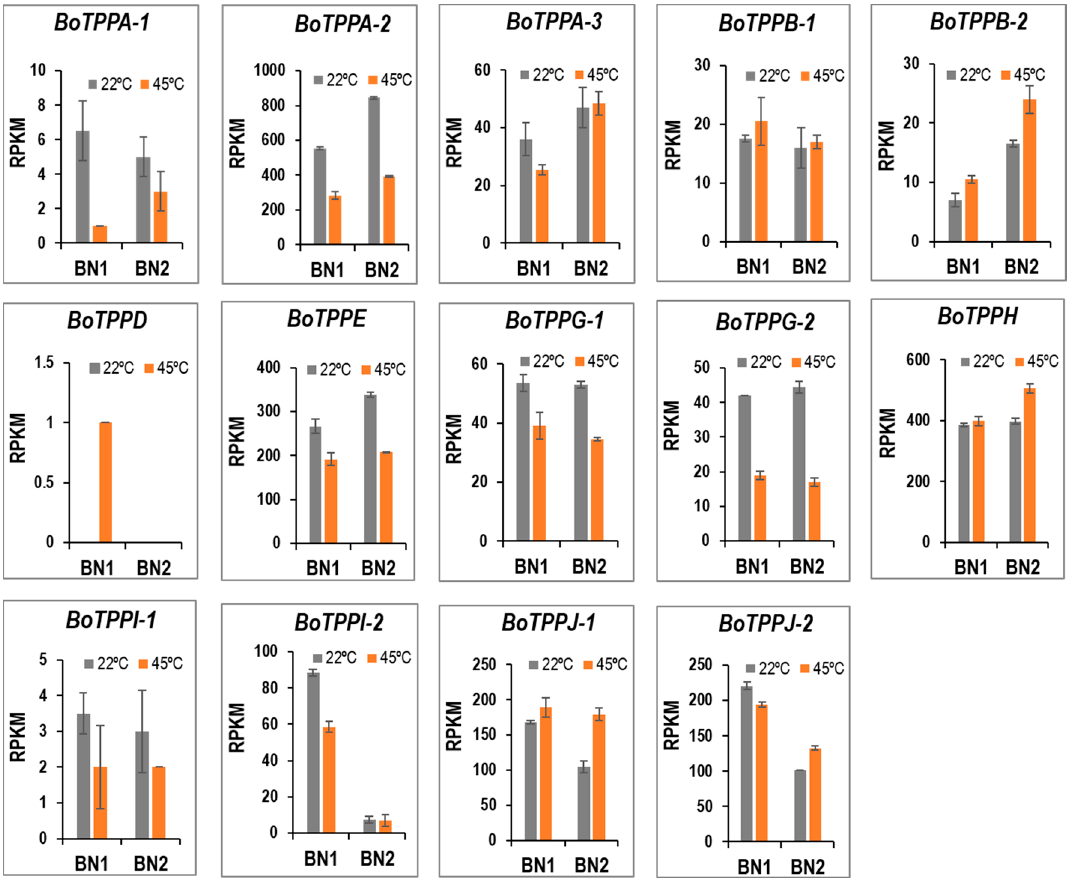
Figure 3. Expression of trehalose-6-phosphate phosphatase (BoTPP) genes under normal conditions (22 °C) and after heat shock (45 °C for 1 h). Expression levels were obtained from RNA-seq data as reads per kilobase of transcript per million mapped reads (RPKM).